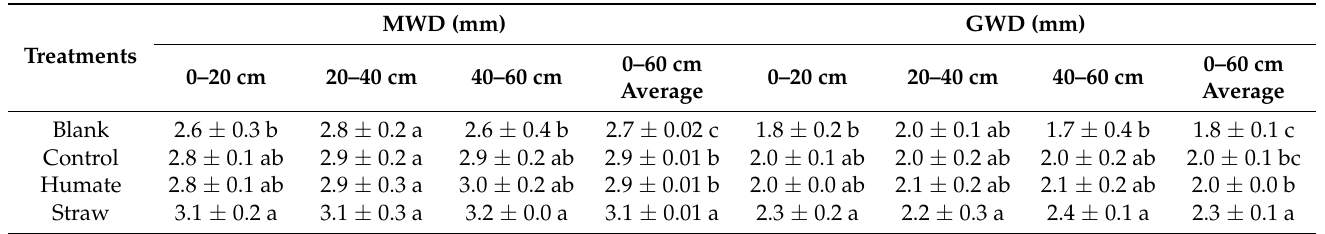
Table 3. The MWD and GMD of the soil aggregates by dry sieving in the different tillage systems at the end of the 3-year experiment in 2018.